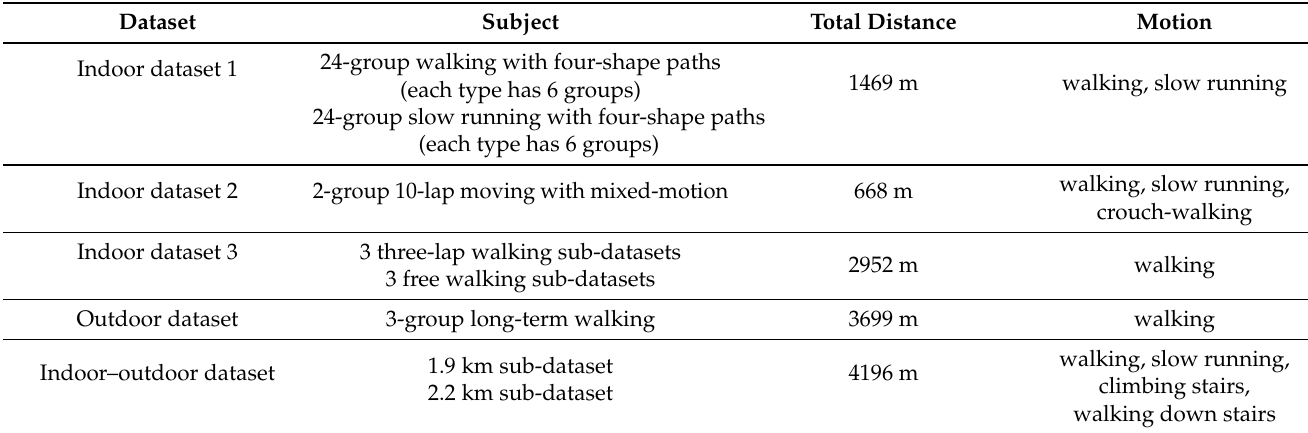
Table 4. Description of the indoor and outdoor loop